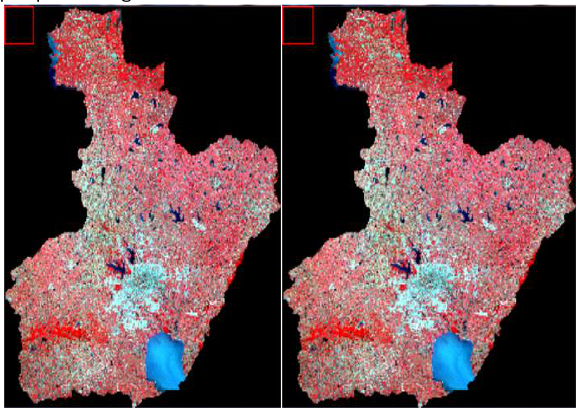
Figure 5 Image map of Hefei city of Anhui Province: the year 2000(left) and 2008(right) ( Band 4,3,2 false color composite map)